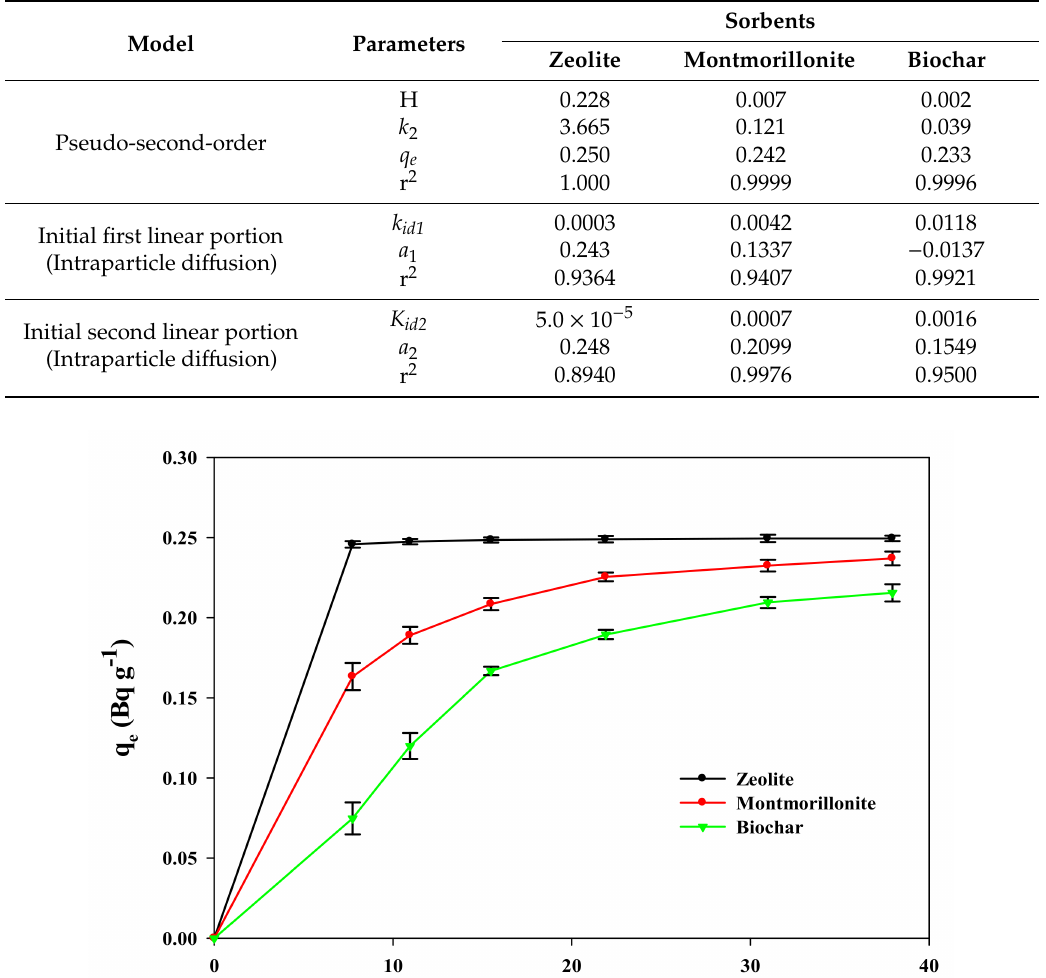
Table 4. Kinetic parameters for 226 Ra adsorption models.